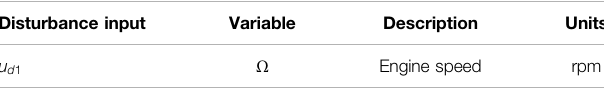
TABLE 4 | Disturbance input variables for the engine